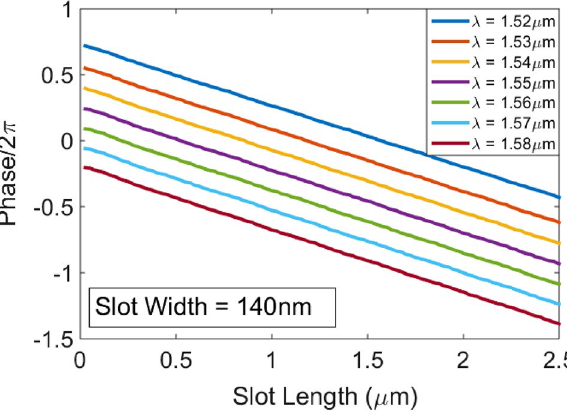
Figure 6. The wavelength-dependent phase shift of a meta-atom versus slot-length, fixing the slot width and height at 140 nm and 250 nm respectively, calculated by Lumerical